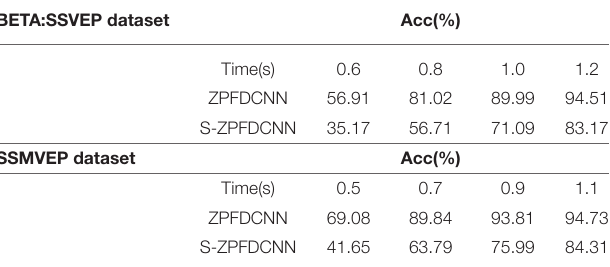
TABLE 5 | The comparison of the average accuracy of the ZPFDCNN method and the S-ZPFDCNN method after 10-fold cross-validation in BETA:SSVEP dataset and SSMVEP